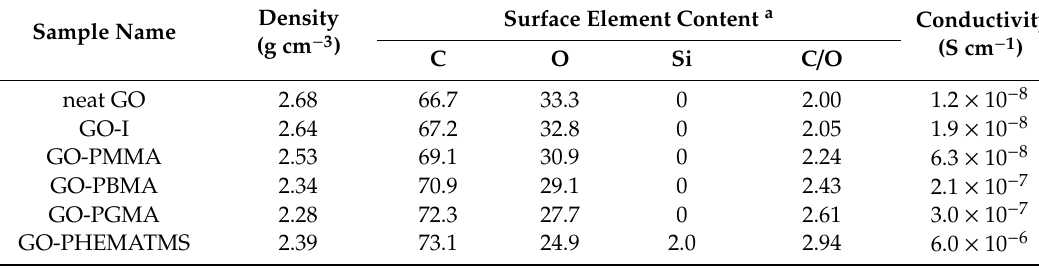
Figure 3. XPS spectra of: ( a ) the neat GO, ( b ) GO-PMMA, ( c ) GO-PBMA, ( d ) GO-PGMA, ( e ) GO- PHEMATMS. Table 2. Densities, surface elements content and conductivities of neat GO and GO-modified particles.